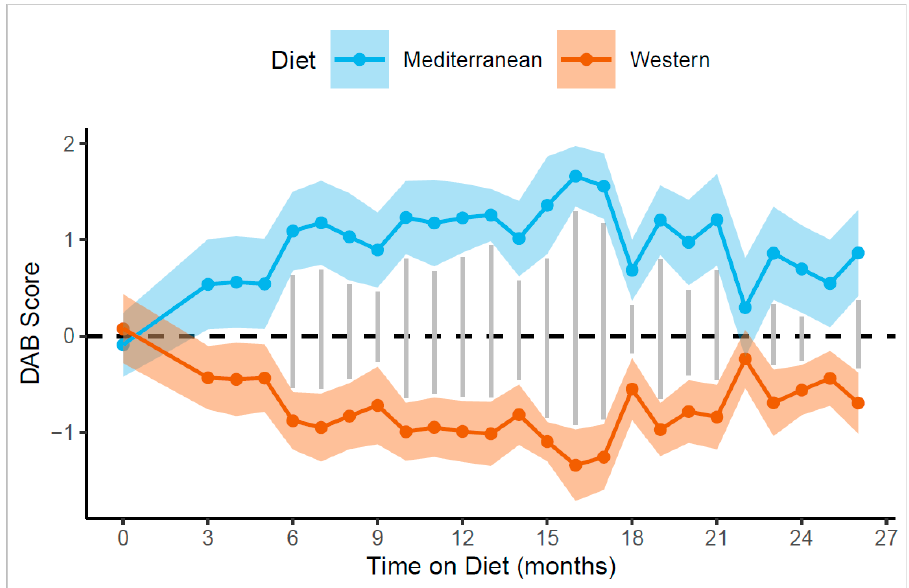
Figure 1. Diet-induced rapid changes in the DAB scores that persisted throughout the experiment. Monkeys consuming the Mediterranean diets (blue points [mean] and ribbons [SEM]) exhibited higher DAB scores in the first month of behavioral observation (three months on experimental diets; F [1,35] = 6.7, p = 0.014), as well as consistently higher DAB scores during the treatment phase than did monkeys consuming the Western diets (orange points [mean] and ribbons [SEM]; F [1,33] = 53.3, p = 2.2 × 10 − 8 ). There was a significant interaction between month and diet (F [10.3,341.2] = 2.2, p = 0.019). Holm–Bonferroni-adjusted post-hoc analyses demonstrated significant differences in 19/24 months at p < 0.05, as indicated by vertical lines between points for each month, and an additional 4/24 months at p <